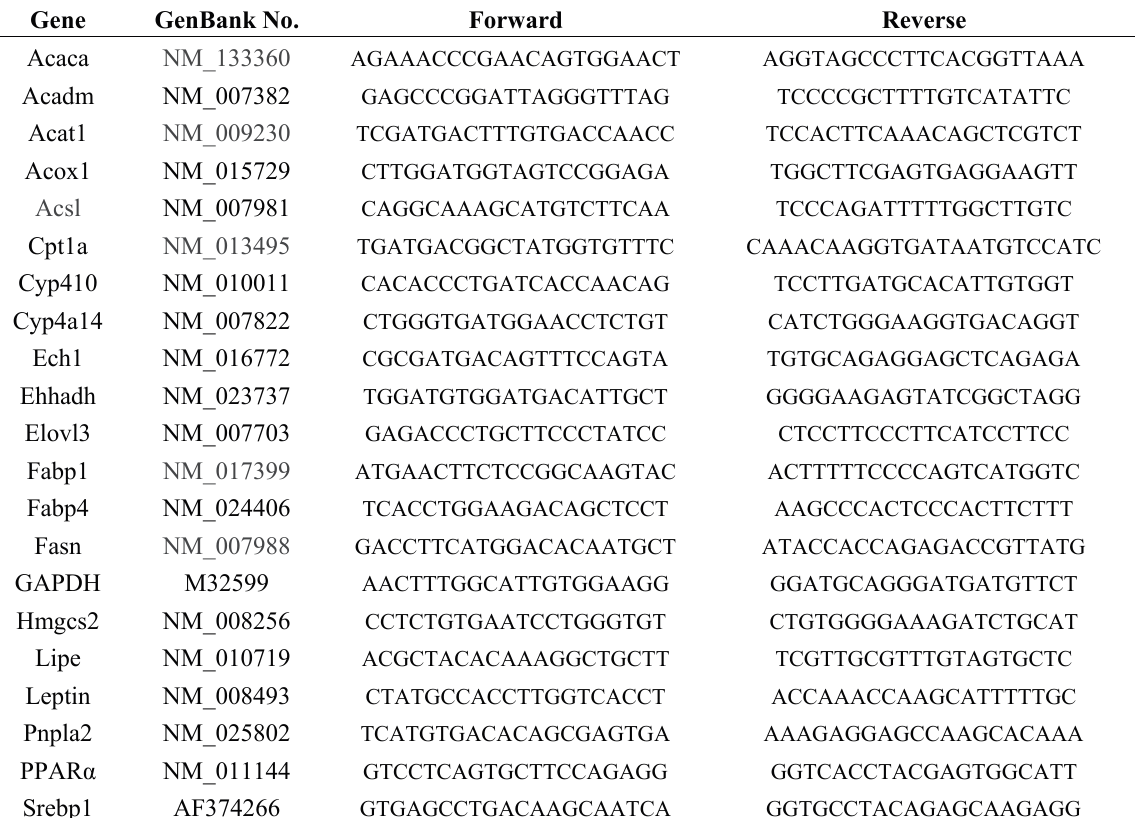
Table 1. Primer sequences for real-time RT-PCR